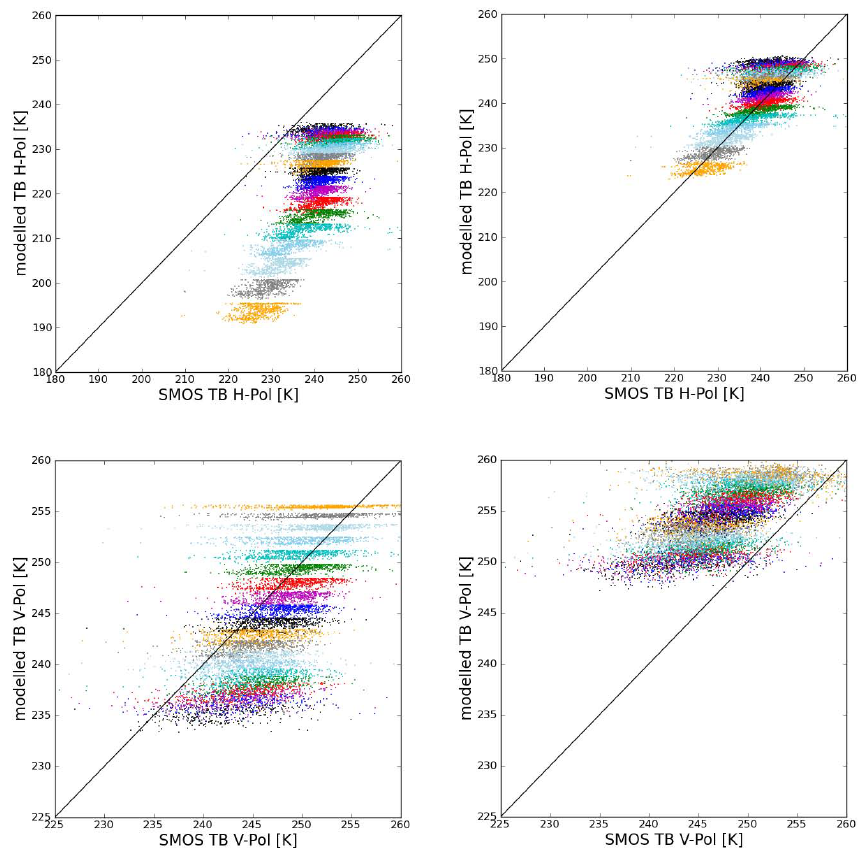
Fig. 5. Brightness temperatures as measured by SMOS vs. brightness temperatures as modelled with the model for one ice layer and the IceBridge ice thicknesses (left figures), and as modelled with the model for one ice and one snow layer and the IceBridge ice and snow thicknesses (right figures), respectively. The upper figures show horizontal polarisation, the lower figures vertical polarisation. The colors indicate the incidence angle increasing from 0 at the upper right corner to 60 ◦ at the lower left corner of the data cloud at horizontal polarisation, and from 0 at the lower left corner to 60 ◦ at the upper right corner at vertical polarisation. Only data points with c ice ≥ 95% and − 37.3 ◦ C < T surf < − 28 . 3 ◦ C are